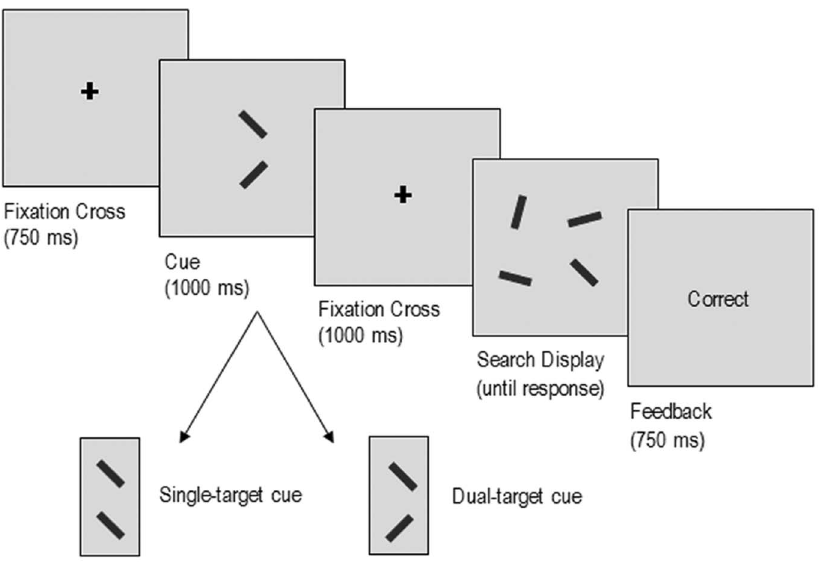
Figure 1. Sequence of events on a single trial with a set size of four. In this example, the cue signals a dual-target search on a target-present trial.